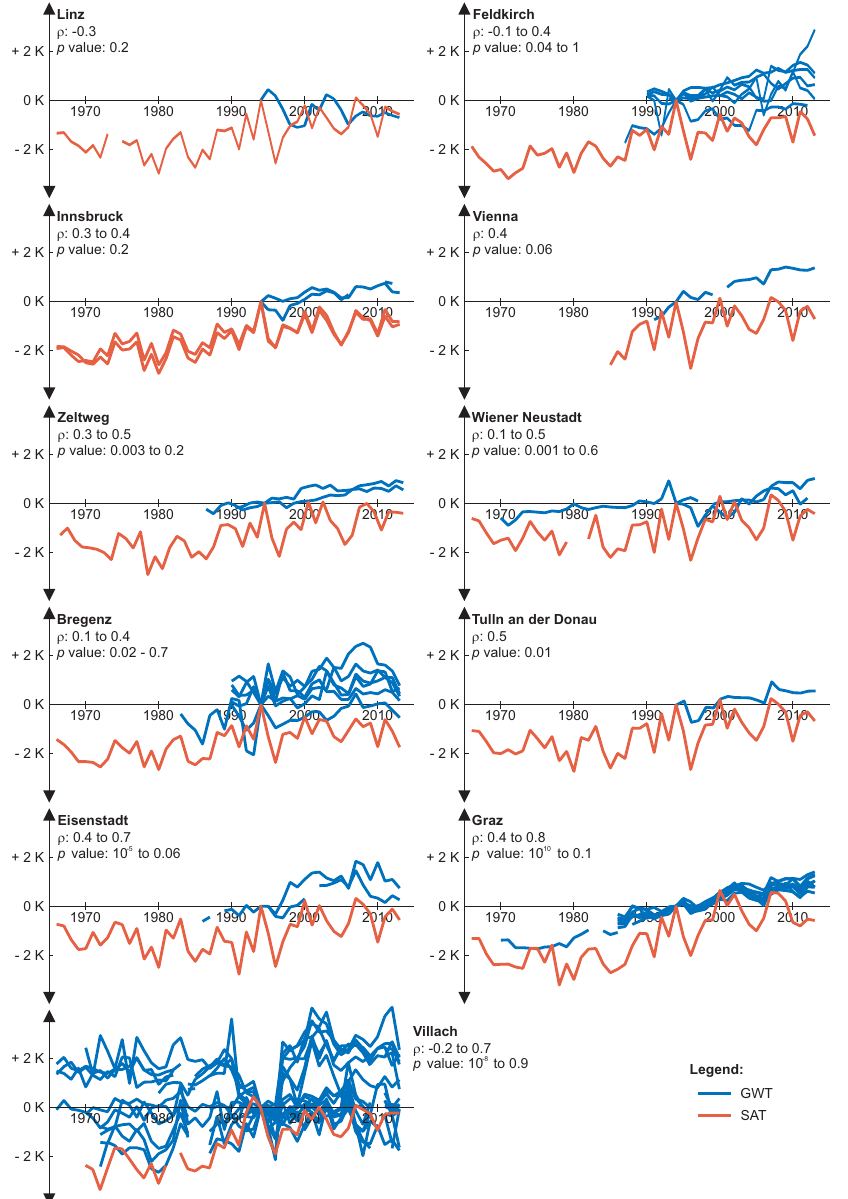
Figure 3. Change from 1994 in surface air temperature (SAT) and groundwater temperatures (GWTs) of all wells within 5km of the analysed weather station. See Fig. S3 for an overview of the locations. Minimum and maximum correlations and p values between individual wells and weather stations are